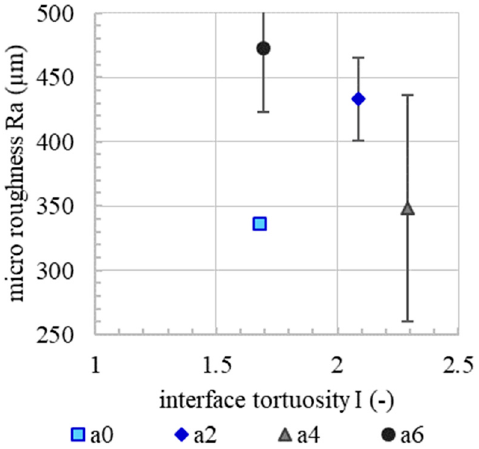
Figure 12. No correlation between initial micro roughness and interface tortuosity for an interlayer time of 0 min.